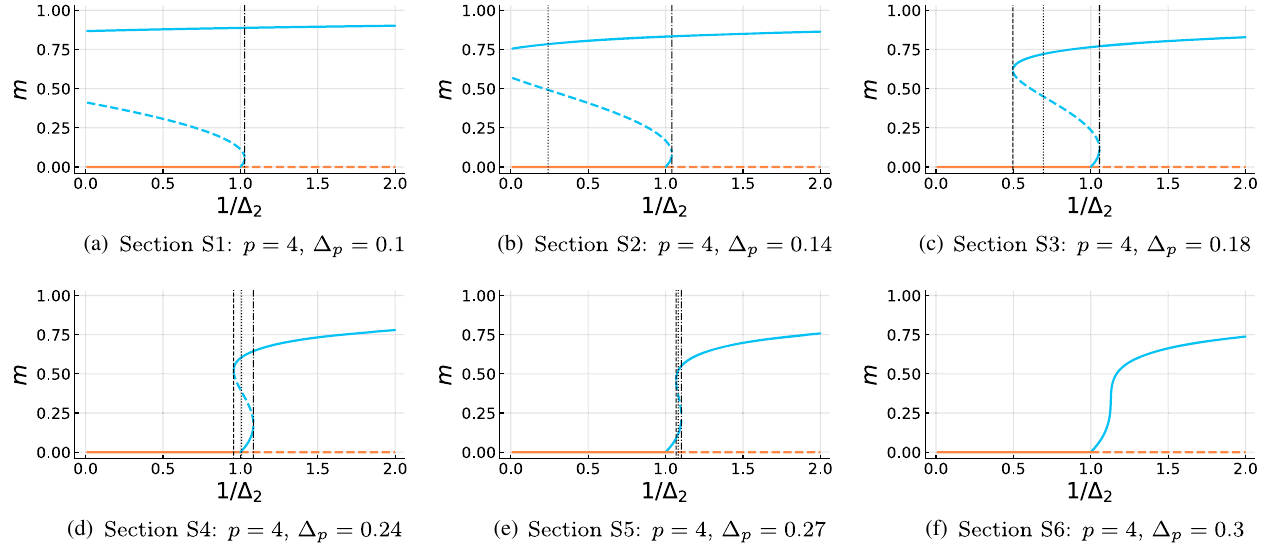
FIG. 10. Fixed points, Eq. (B37), as a function of Δ 2 for p ¼ 4 and several fixed values of Δ correspond to the vertical cuts of the right panel of Fig. 7. The situation is qualitatively similar to Fig. 9, the difference being only the presence of the hybrid-hard phase. We can observe that when the transition is discontinuous, from (a) to (e), for 1 = Δ 1 . 0 , the uninformative solution becomes unstable and continuously goes to a stable-informative solution, which is not the 2 > optimal